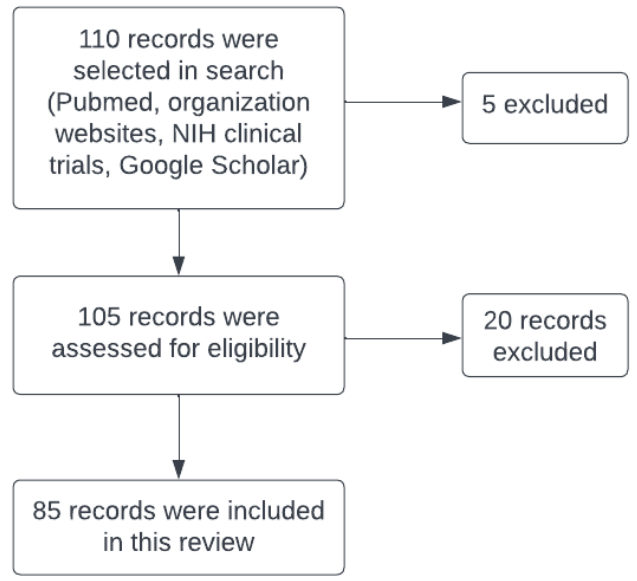
Figure 1. Flow Search Diagram.